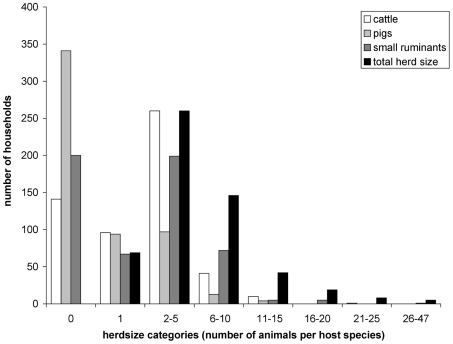
Distribution of household herdsizes.Number of households per category of herdsize for each host species and for total herdsize.